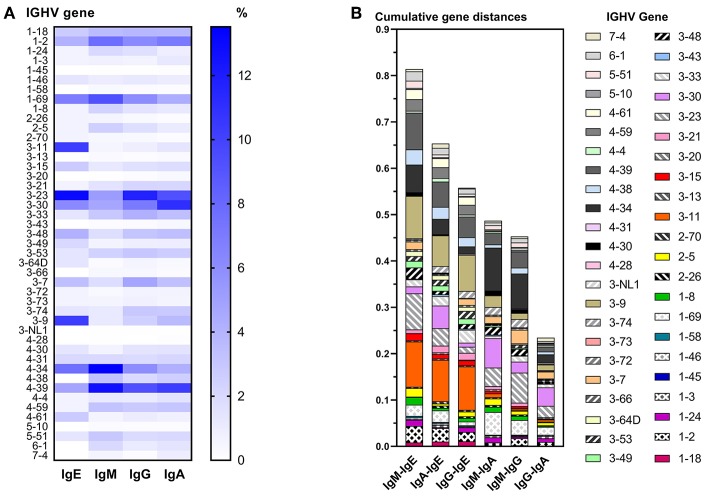
Differential IGHV usage between isotypes. (A) Heat map indicating the relative frequency of all IGHV genes among unique VDJ sequences per isotype. For each isotype, the frequencies shown add up to 100%. (B) Pairwise comparison of cumulative IGHV gene distance between two isotypes. For each IGHV gene, the fractions of VDJ sequences containing that IGHV gene within an isotype were calculated, and the numerical difference of these fractions between two isotypes was determined per IGHV gene. For each pairwise comparison between isotypes, all differences of IGHV gene fractions were added to obtain their cumulative distance.